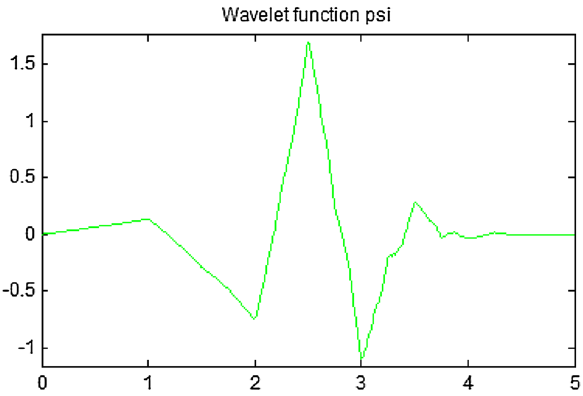
Fig. 8 Waveform of Db3 wavelet function